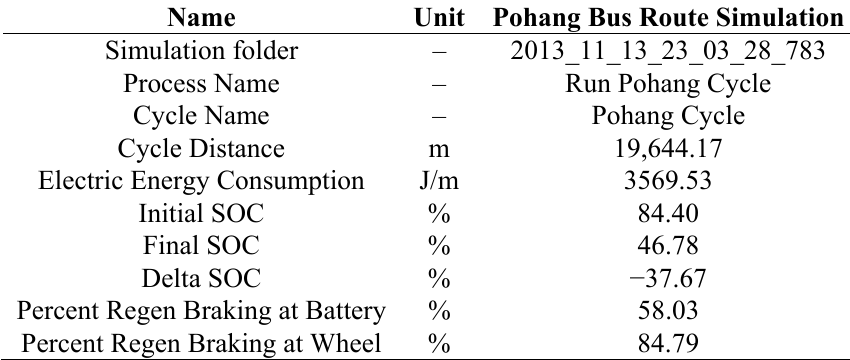
Table 5. Summary of simulation